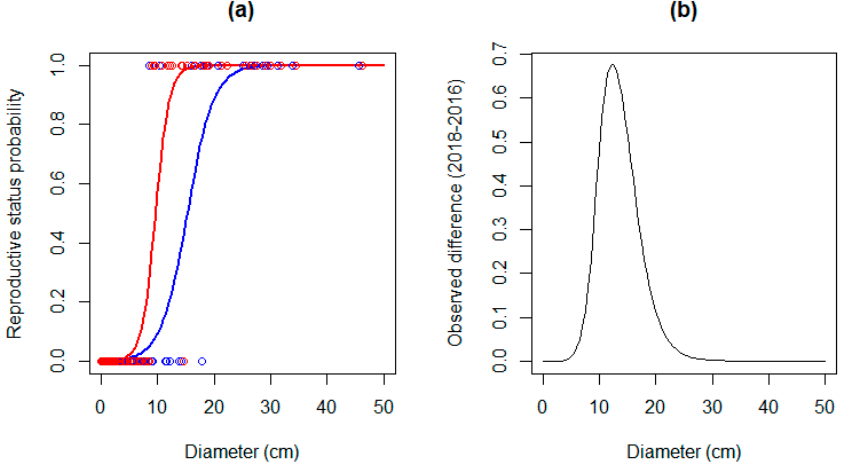
Figure 3. ( a ) Reproductive status probability in relation to diameter for 2016 (blue) and 2018 (red); ( b ) observed difference between both reproductive probability curves.